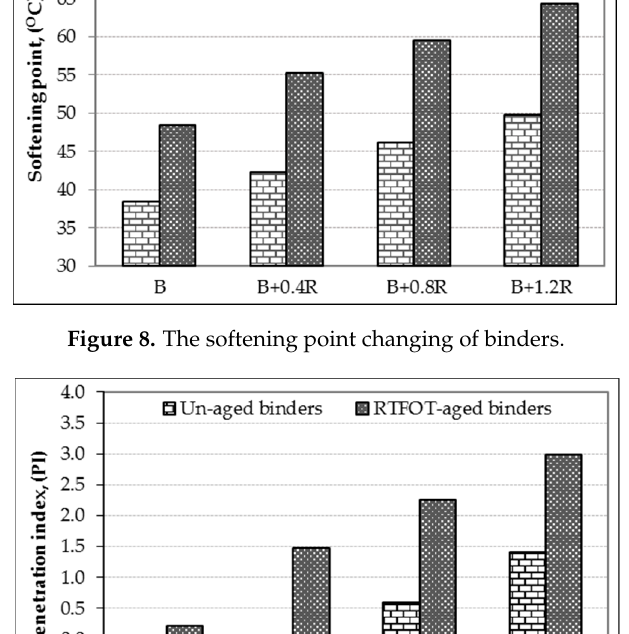
Figure 7. The penetration changing of binders.